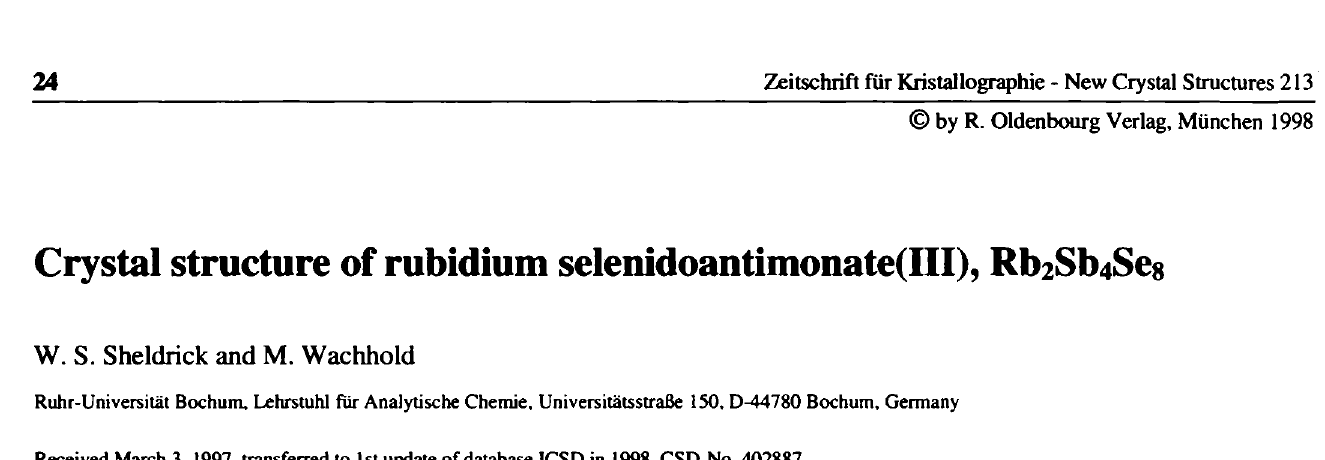
Table 1. Parameters used for the X-ray data collection Crystal: